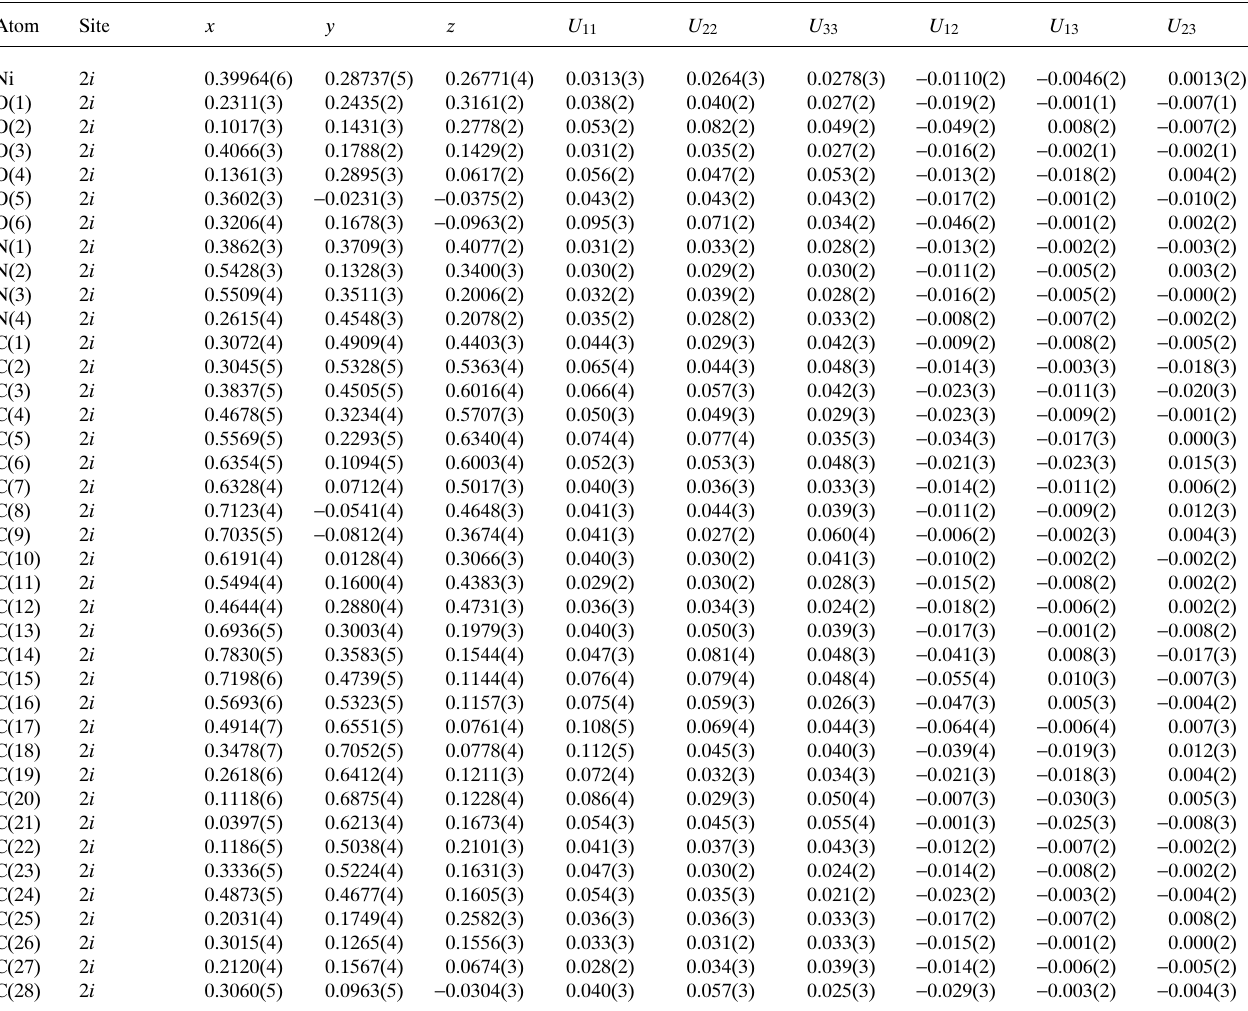
Table 3. Atomic coordinates and displacement parameters (in Å 2 ) .